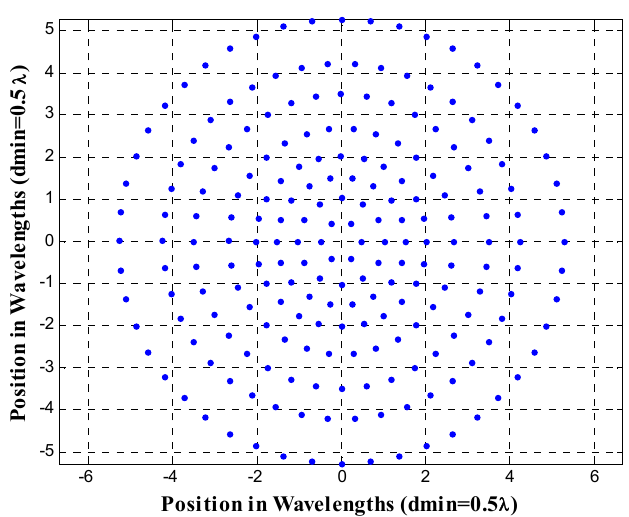
Figure 6. Antenna array configuration of the design case UW-ACRA rings of N T = 216 antenna elements with N r = 8 rings at a frequency f = f 0 , corresponding to a minimum element spacing of 0.5 λ .